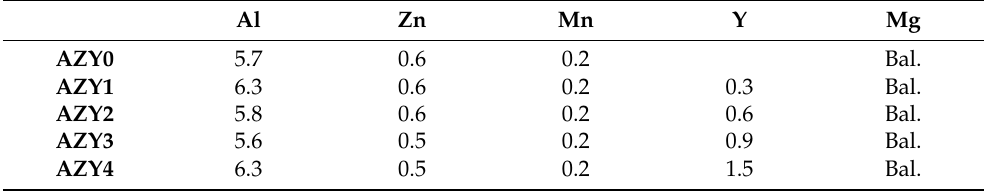
Table 1. Composition analysis of the AZ61 sheets with different Y contents (wt.%).